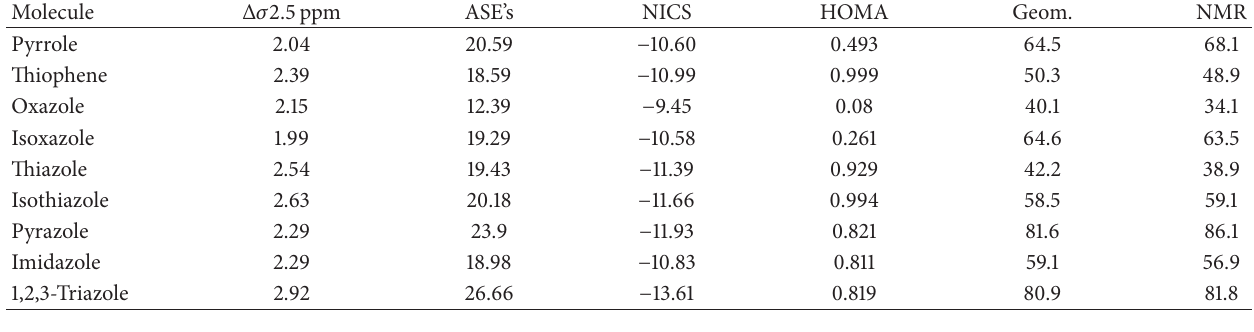
Table 4: Comparison of our results (Geom. and NMR) with NICS, ASE’s, and NMR shielding values [59] for five membered heterocyclic rings.